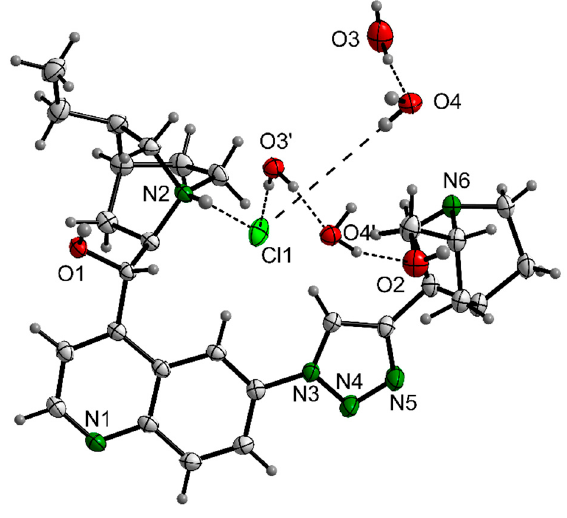
Figure 5. The X-ray analysis for compound 28 .